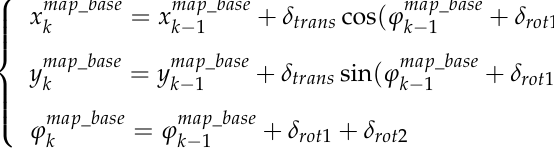
Figure 10. Search time from coarse to fine